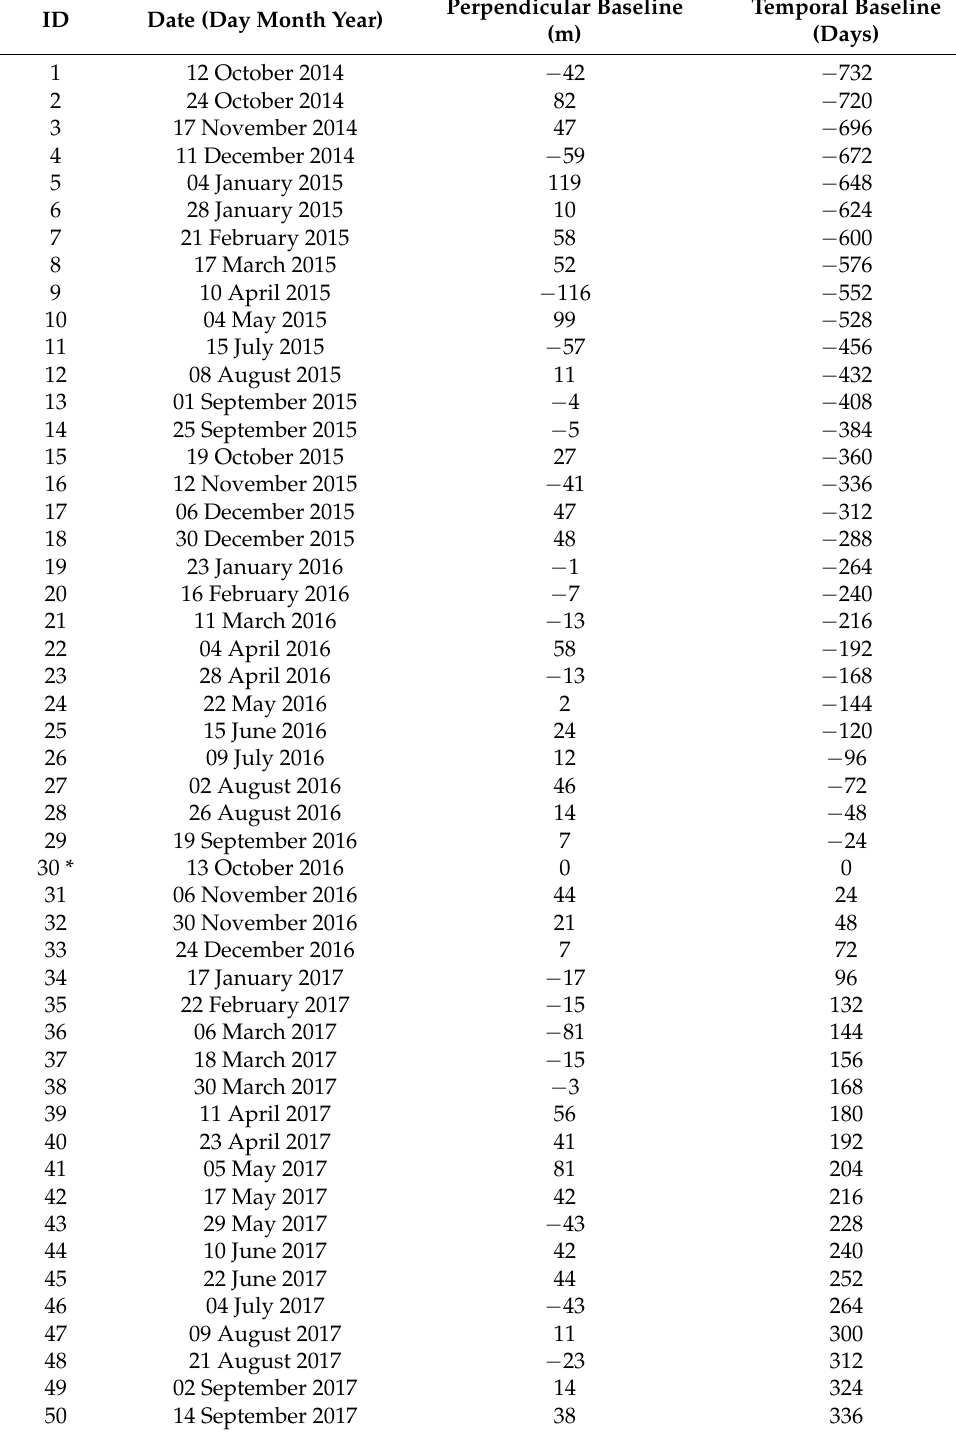
Table 2. Sentinel-1 A/B